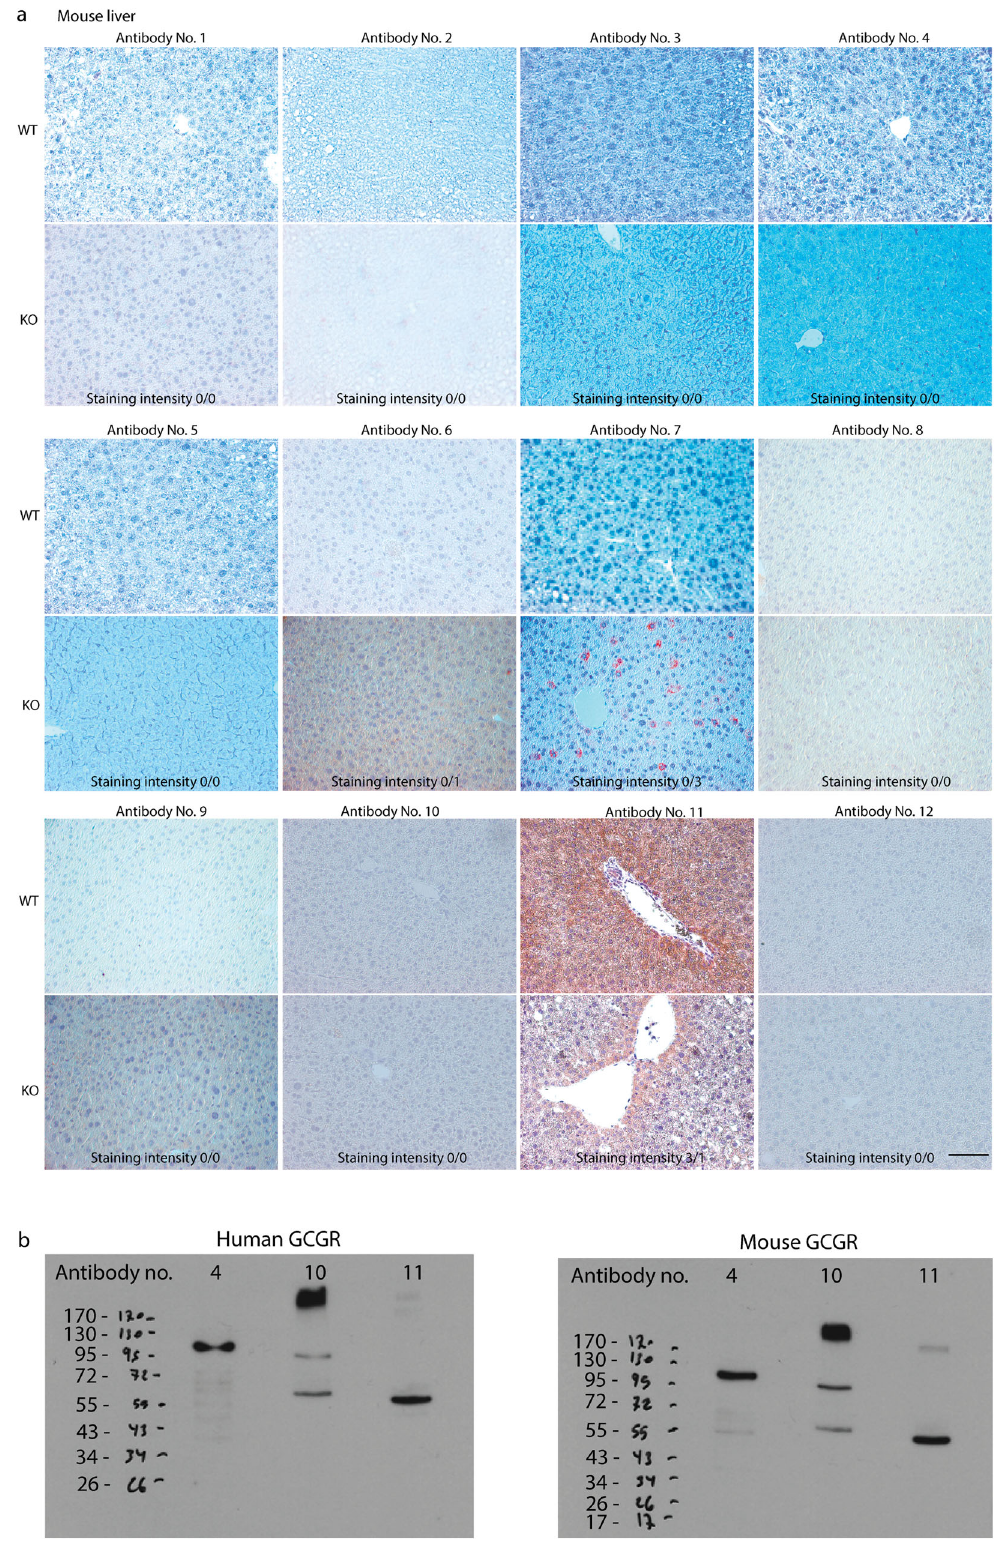
Fig. 2 Evaluation of selected antibodies. a Immunohistochemical staining of liver tissue from either the glucagon receptor wildtype ( Gcgr + / + ) or glucagon receptor knockout ( Gcgr − / − ) female mice, 8 weeks of age, using the 12 GCGR antibodies (1:100). Staining intensity scores between 0 and 3 of liver tissues from both the Gcgr + / + and Gcgr − / − mice are presented, the higher the score, the more receptor-antibody binding. X40, scale bar = 50 µ m. The observed differences in background in the slides are suspected to be related to hematoxylin staining. b Uncropped western blots of transfected cells with either human glucagon receptor (GCGR) cDNA or mouse GCGR cDNA. Western blotting performed with selected antibodies no. 4, 10 and 11 (1:500). Uncropped western blots of a mock transfection showing a negative staining with antibody no. 11. and a western blot with loading control GAPDH are shown in Fig. S3.